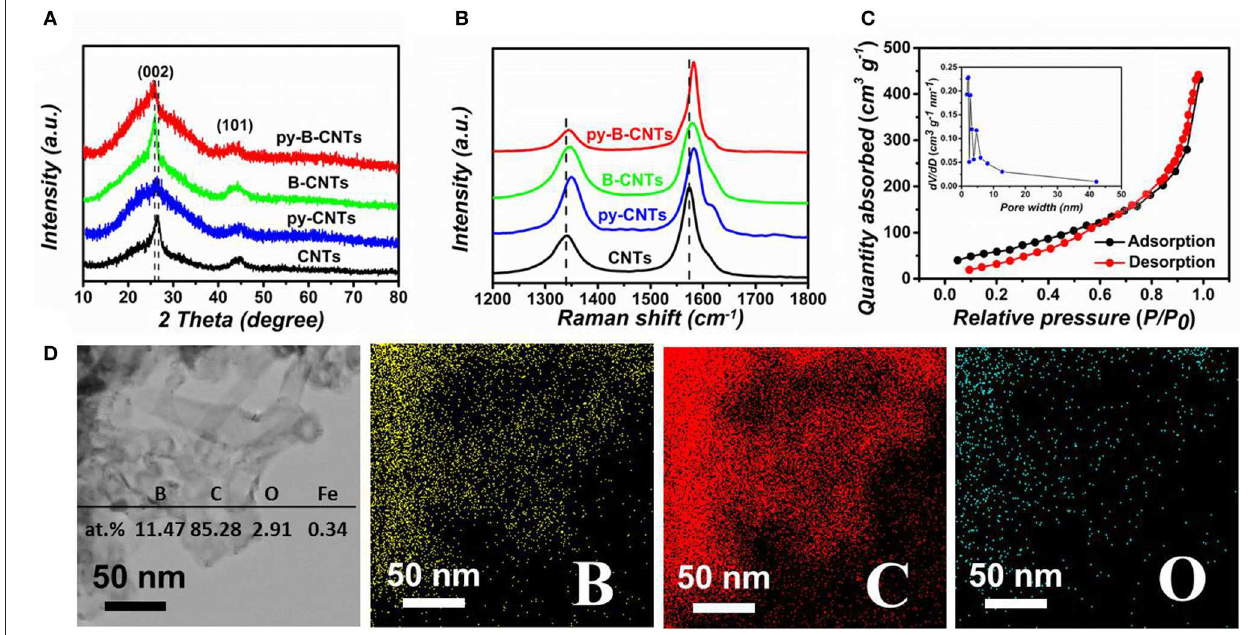
FIGURE 3 | (A) XRD patterns and (B) Raman spectra of the samples; (C) nitrogen adsorption/desorption isotherms with the pore-size distribution (inset) of py-B-CNTs film; (D) the EDS elemental analysis of py-B-CNTs and corresponding elemental mapping of the